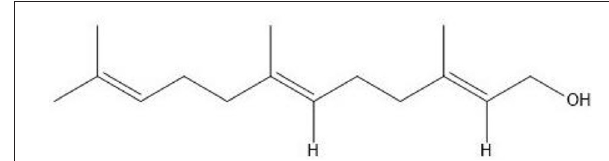
FIGURE 4 | Structure of